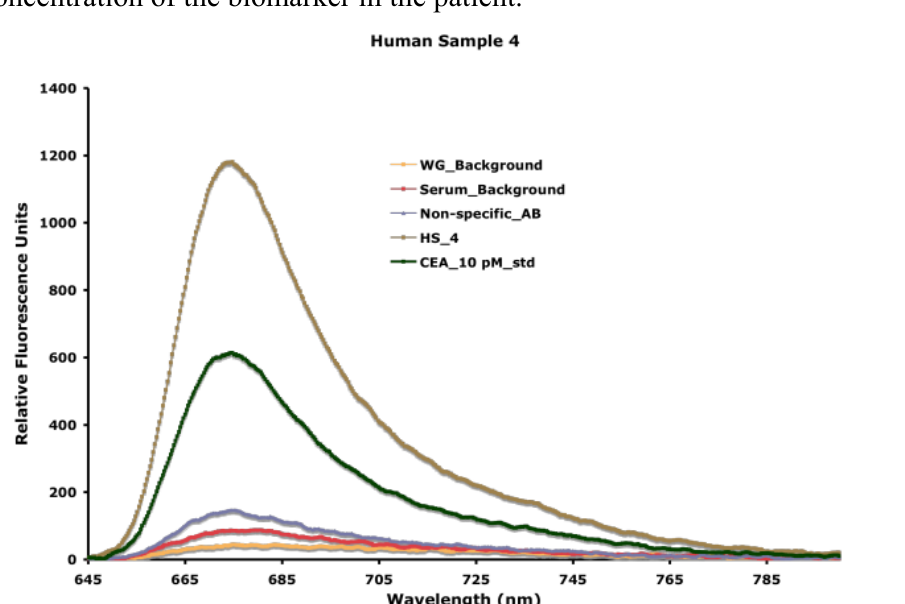
Figure 12. The output of a typical assay on the waveguide-based biosensor is shown. Waveguide-associated background and non-specific binding associated with control sample and the fluorescence reporter are measured in each experiment. Standard measurement of a known concentration of the biomarker of interest is then made (in this case, 10 pM of carcinoembryonic antigen, a breast cancer biomarker), followed by measurement of the biomarker concentration in an unknown patient sample (in this case, HS4). The signal measured is extrapolated against the internal standard to determine the accurate concentration of the biomarker in the